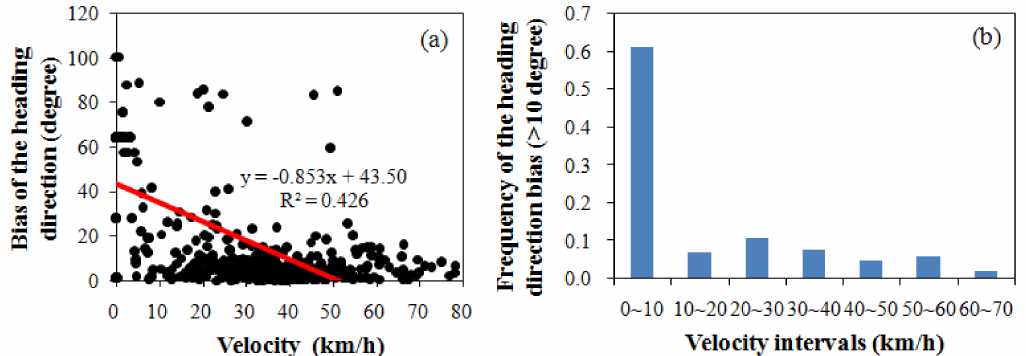
Figure 13. Influence of velocity on heading direction. ( a ) represents the correlation between the velocity and the heading direction bias. ( b ) displays the frequency histogram of the heading direction bias, which exceeds 10 degrees at various velocity